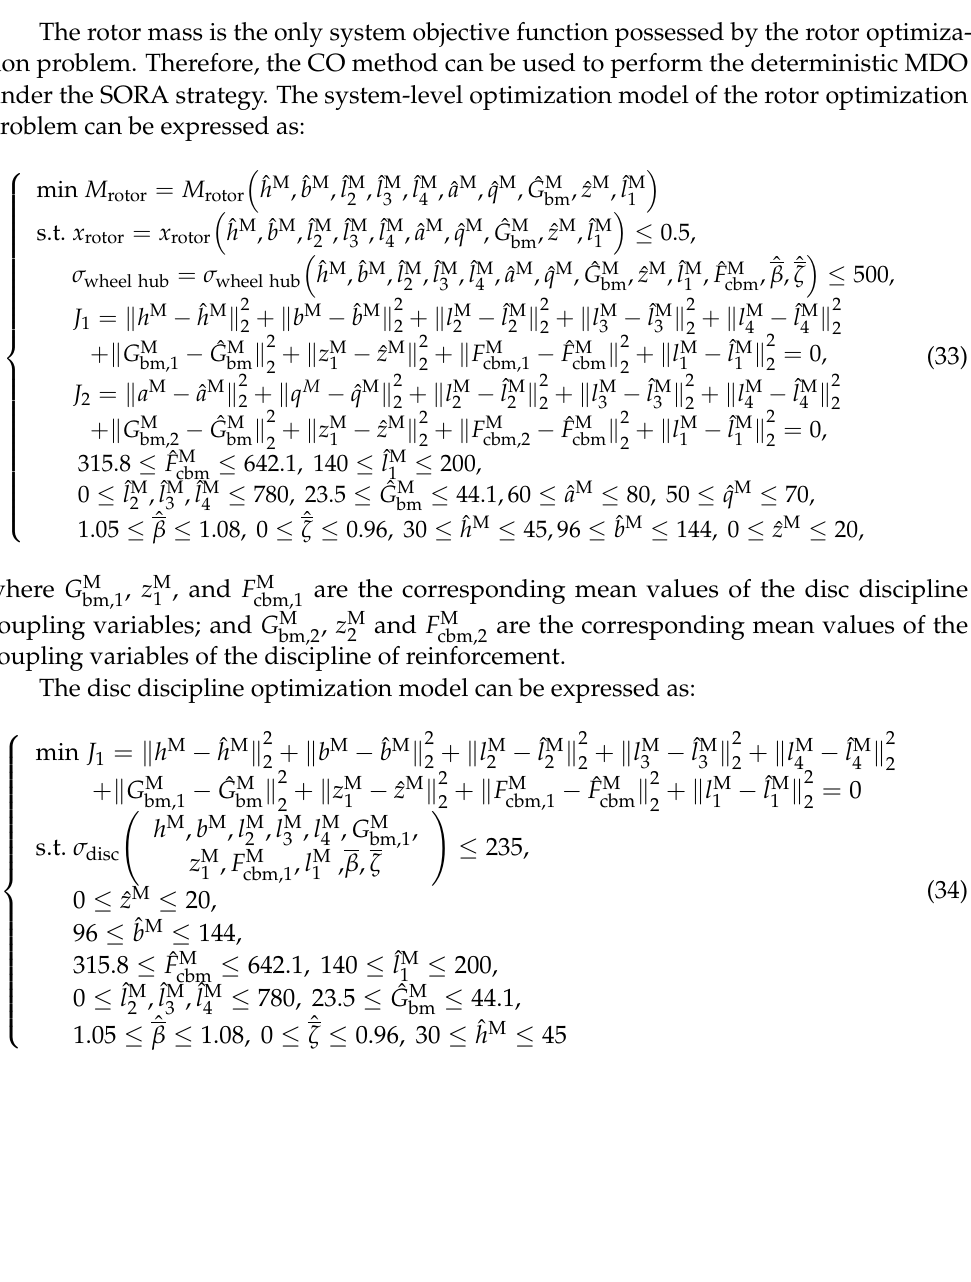
Figure 12. Flow chart of the rotor mechanism optimization considering mixed uncertainties.